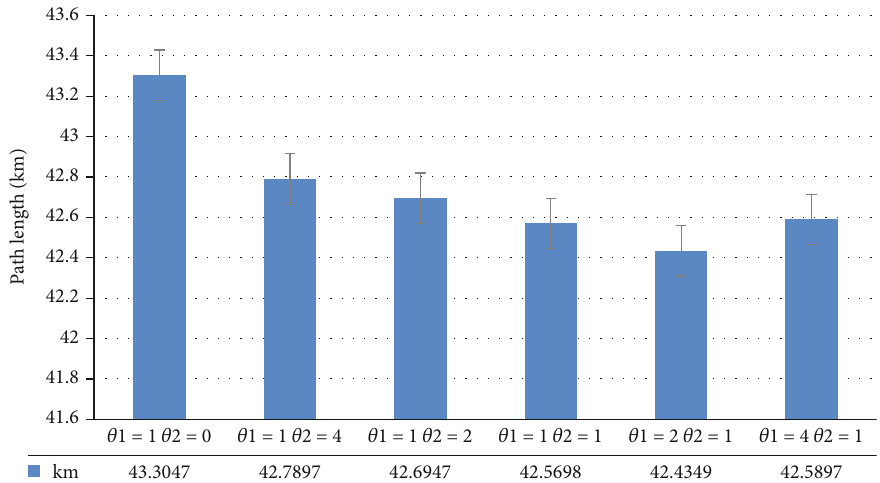
Figure 8: Comparison of path length obtained for H-DQN in di ff erent reward coe ffi cients. The interval on each bar denotes the standard deviation of the path length.